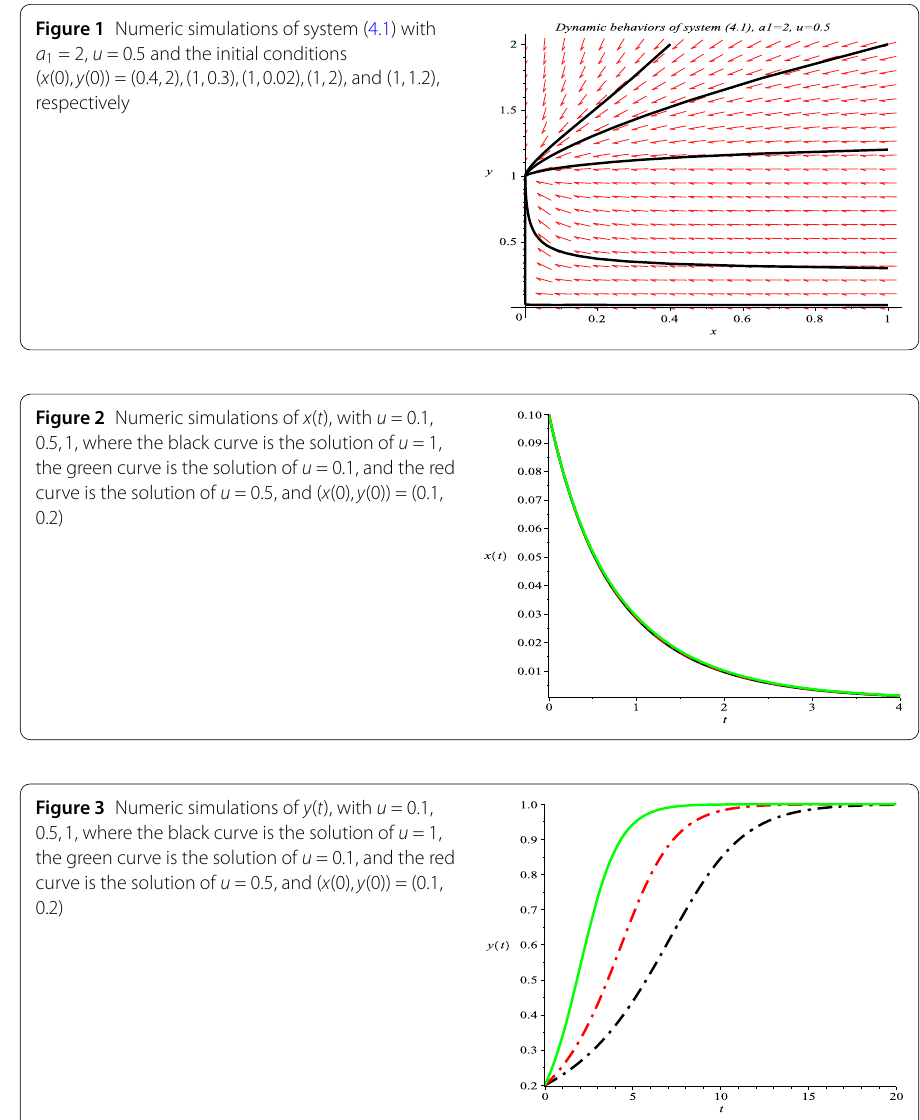
Figure 3 Numeric simulations of y ( t ), with u = 0.1, 0.5,1, where the black curve is the solution of u = 1, the green curve is the solution of u = 0.1, and the red curve is the solution of u = 0.5, and ( x (0), y (0)) = (0.1,